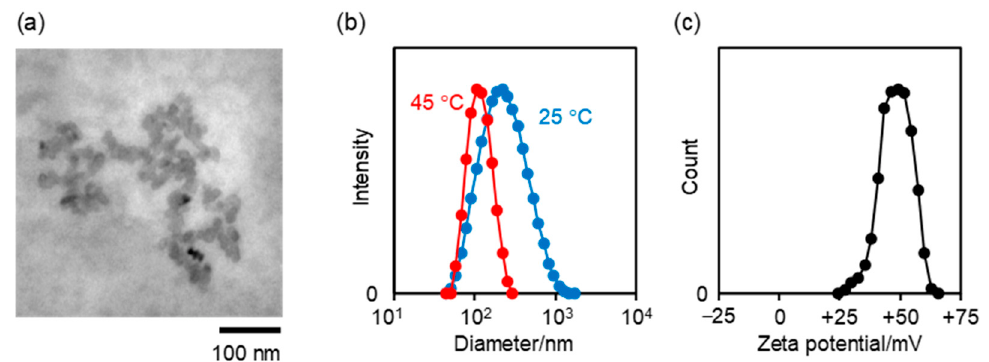
Figure 2. Characterization of NANOGEL- 1 as a representative. ( a ) TEM image; ( b ) size distribution measured by DLS (0.001 w/v% in water at 25 and 45 °C); ( c ) zeta potential distribution (0.1 w/v% in water at 45 °C).